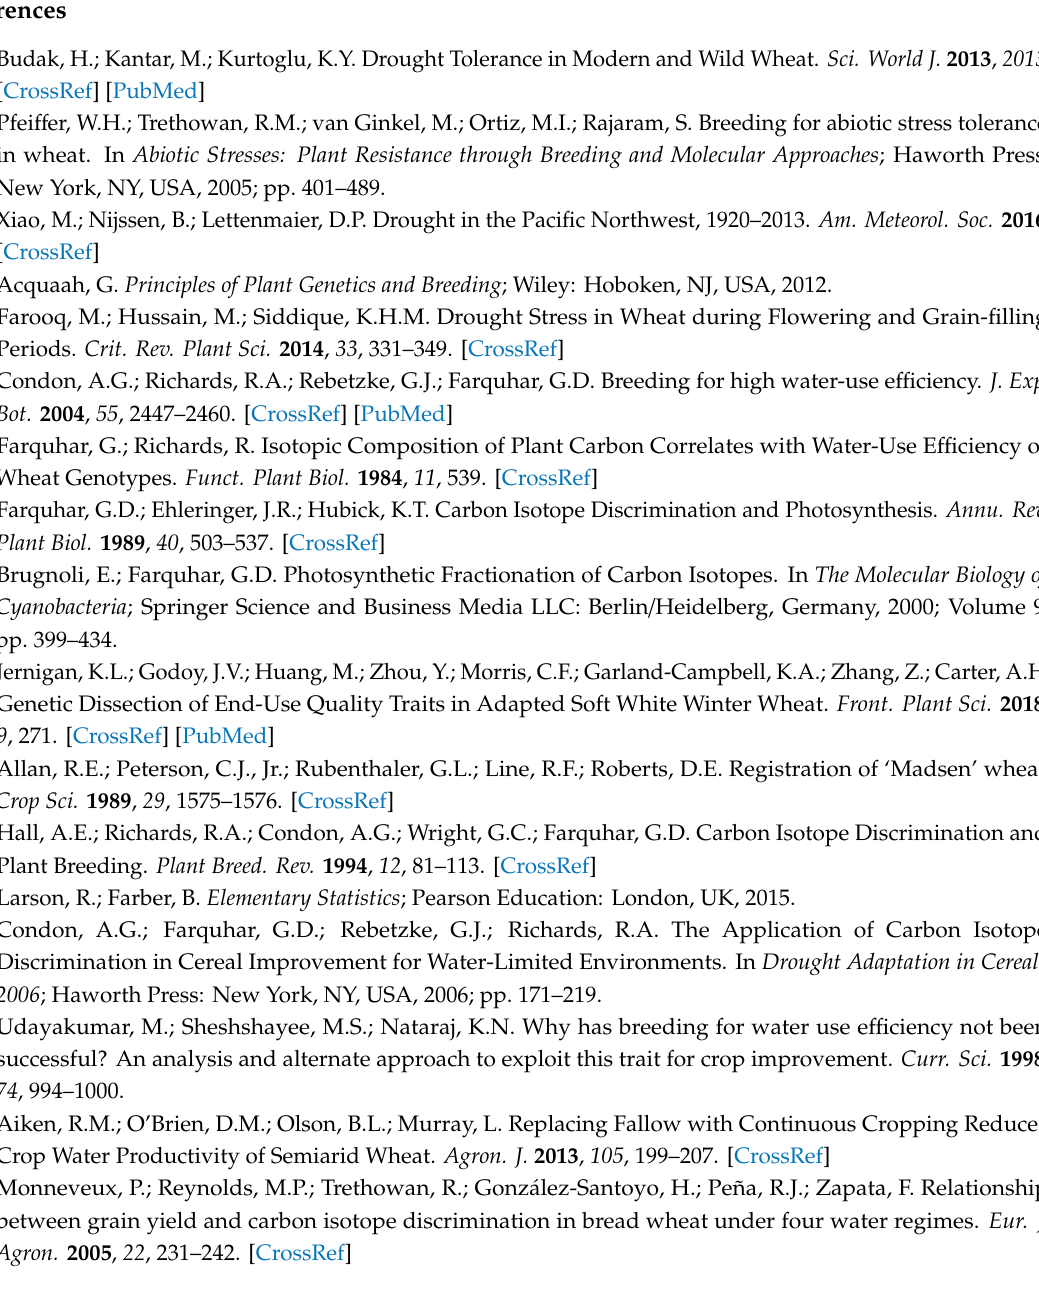
Table S1: Index for relative comparison of ∆ , grain yield (GY), plant height (HT), and heading date (HD) between environments; Table S2: Monthly and total precipitation (mm) occurring over the growing season for each location-year; Table S3: Average maximum temperature ( ◦ C) per month during the growing season for each location-year and average maximum temperature ( ◦ C) over the entire growing season for each